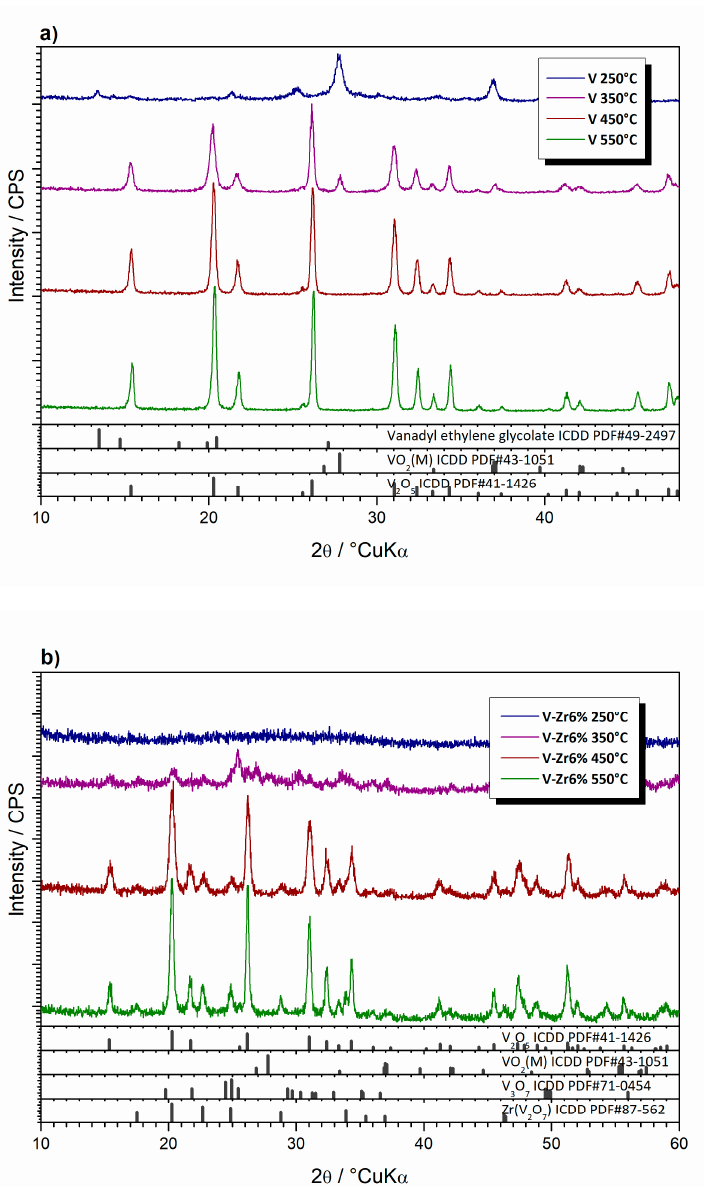
Figure 10. X-ray di ff raction patterns of samples ( a ) pure V and ( b ) V-Zr6%, the thermal treatment of which was interrupted at 250, 350, 450, and 550 ◦